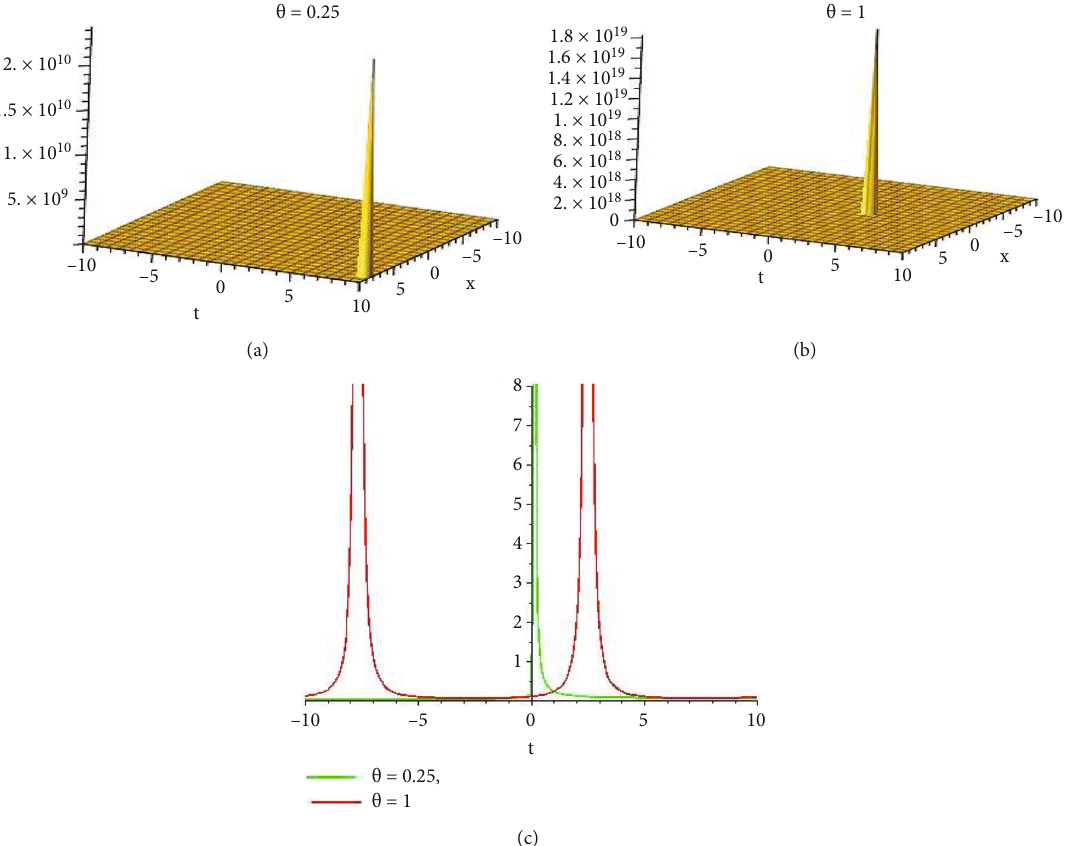
ffiffiffiffiffiffiffiffiffiffiffiffiffiffiffiffiffiffiffiffiffiffiffiffiffiffi p 16 βλμ n 3 + 1